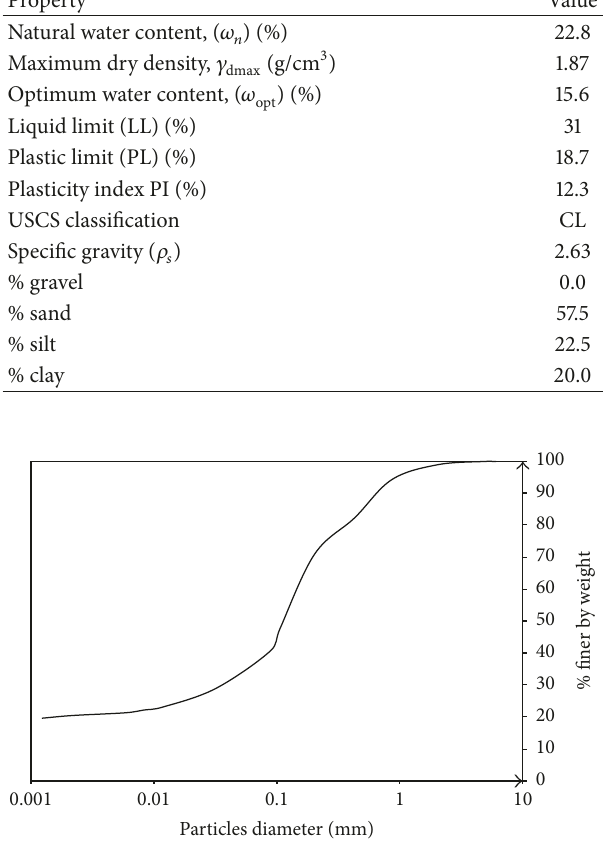
Figure 1: Particles sizes distribution curve of original